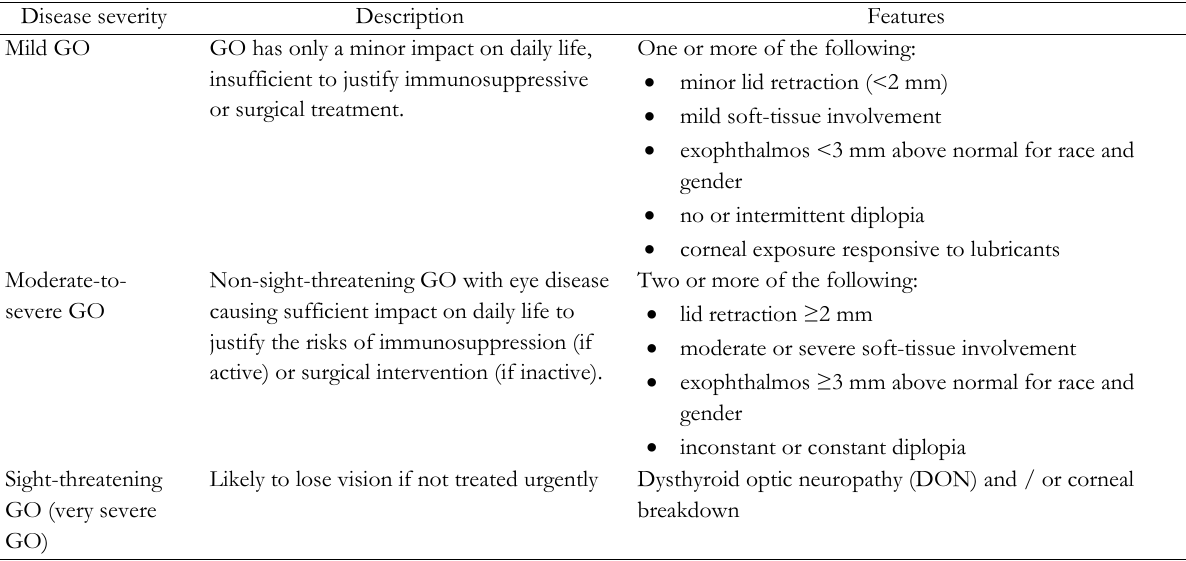
Table 3.13. EUGOGO severity classification of GO